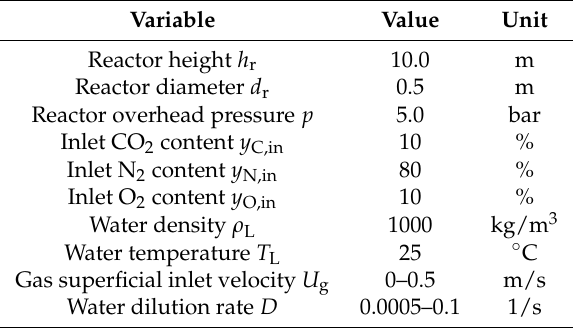
Table 1. Parameters of the scale-up study.